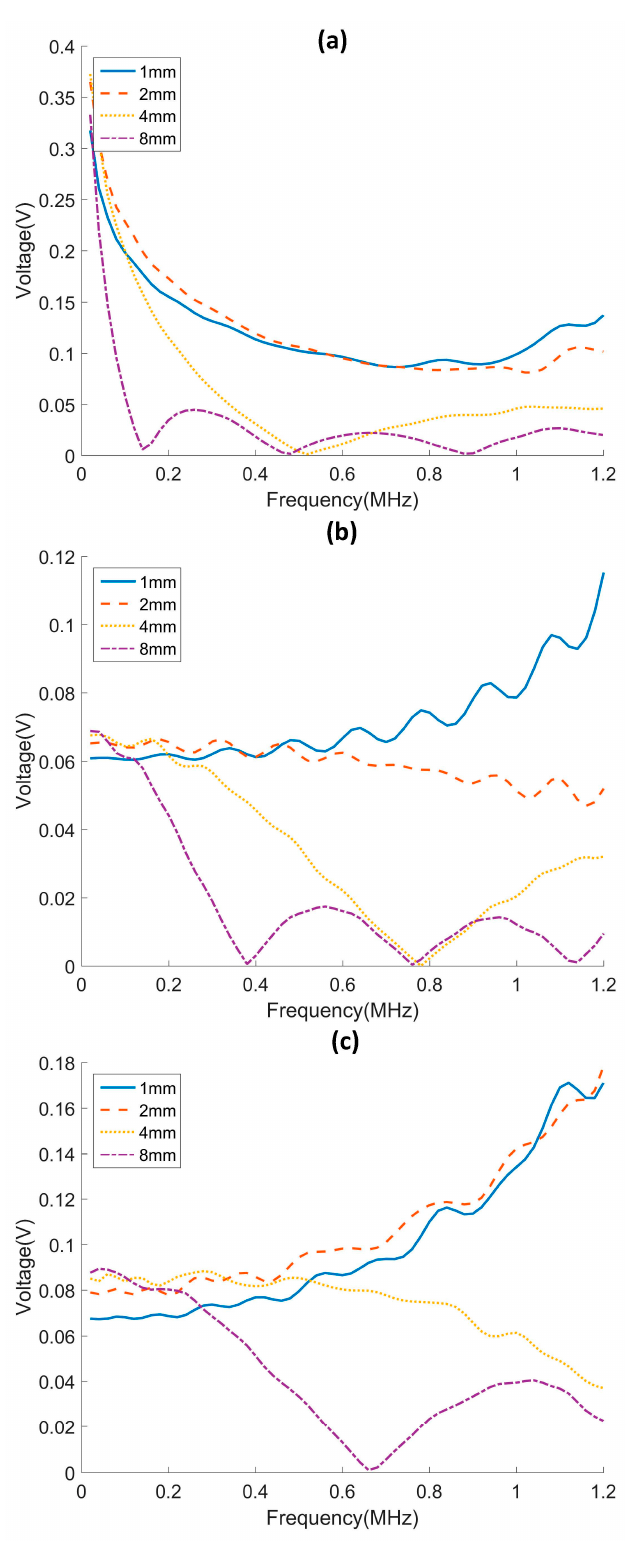
Figure 6. Voltage responses of PVDF films having different widths for ( a ) A0, ( b ) SH0 and ( c ) S0 incidence.